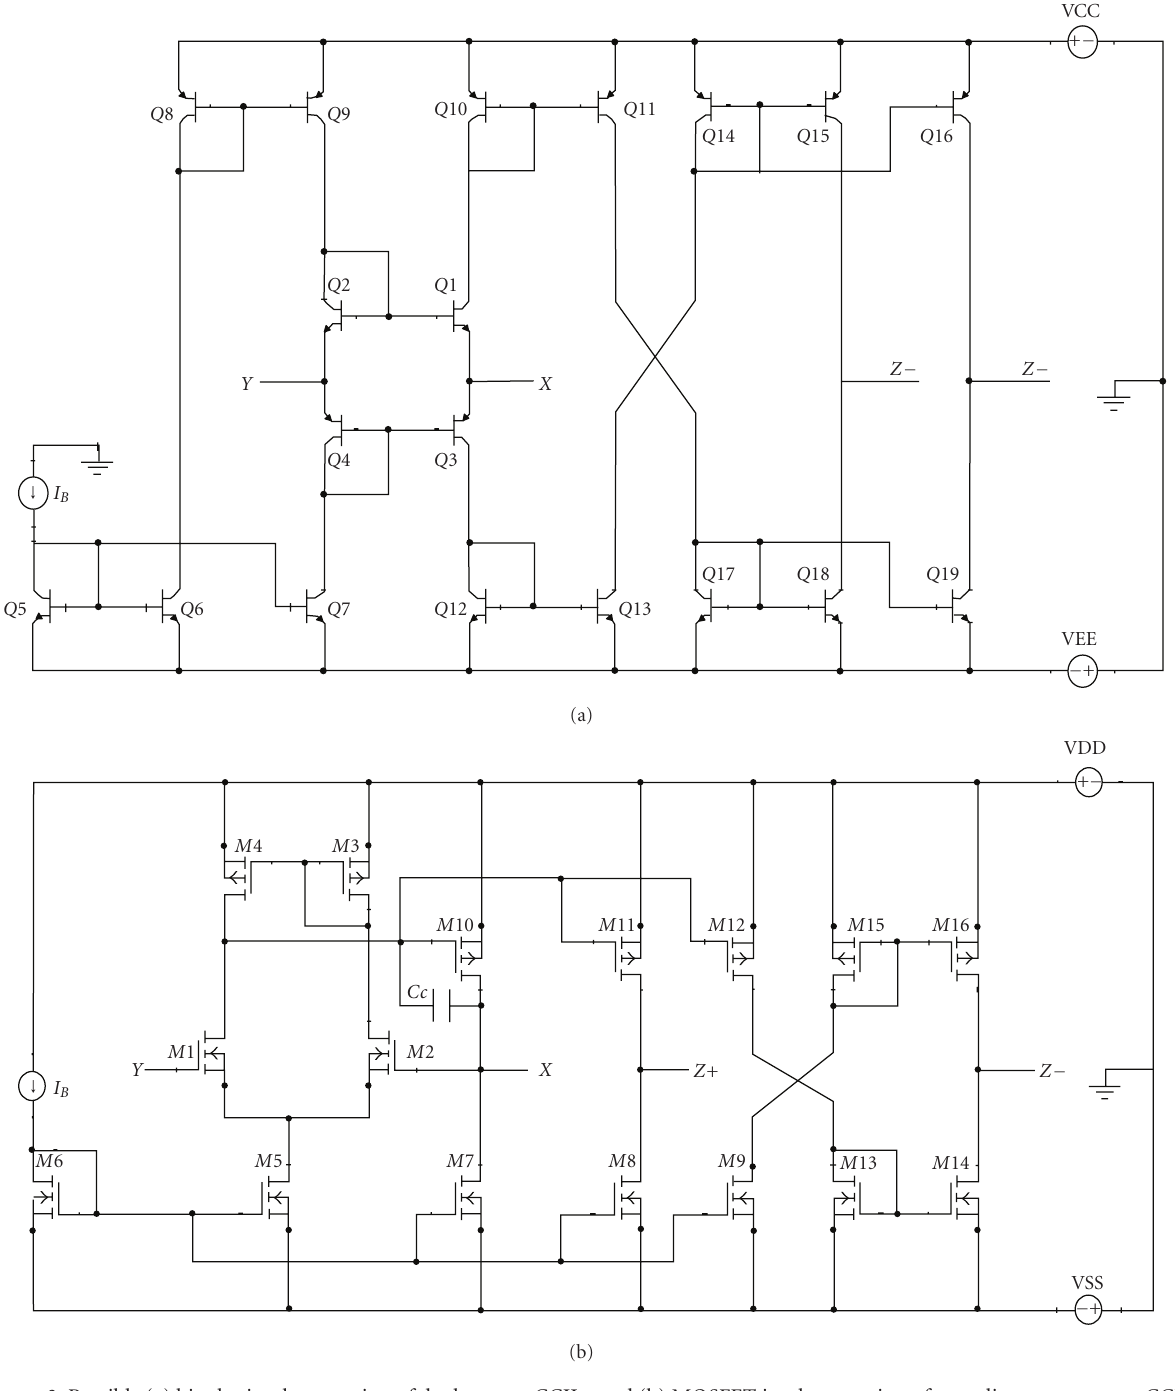
Figure 3: Possible (a) bipolar implementation of dual-output CCII − and (b) MOSFET implementation of complimentary output